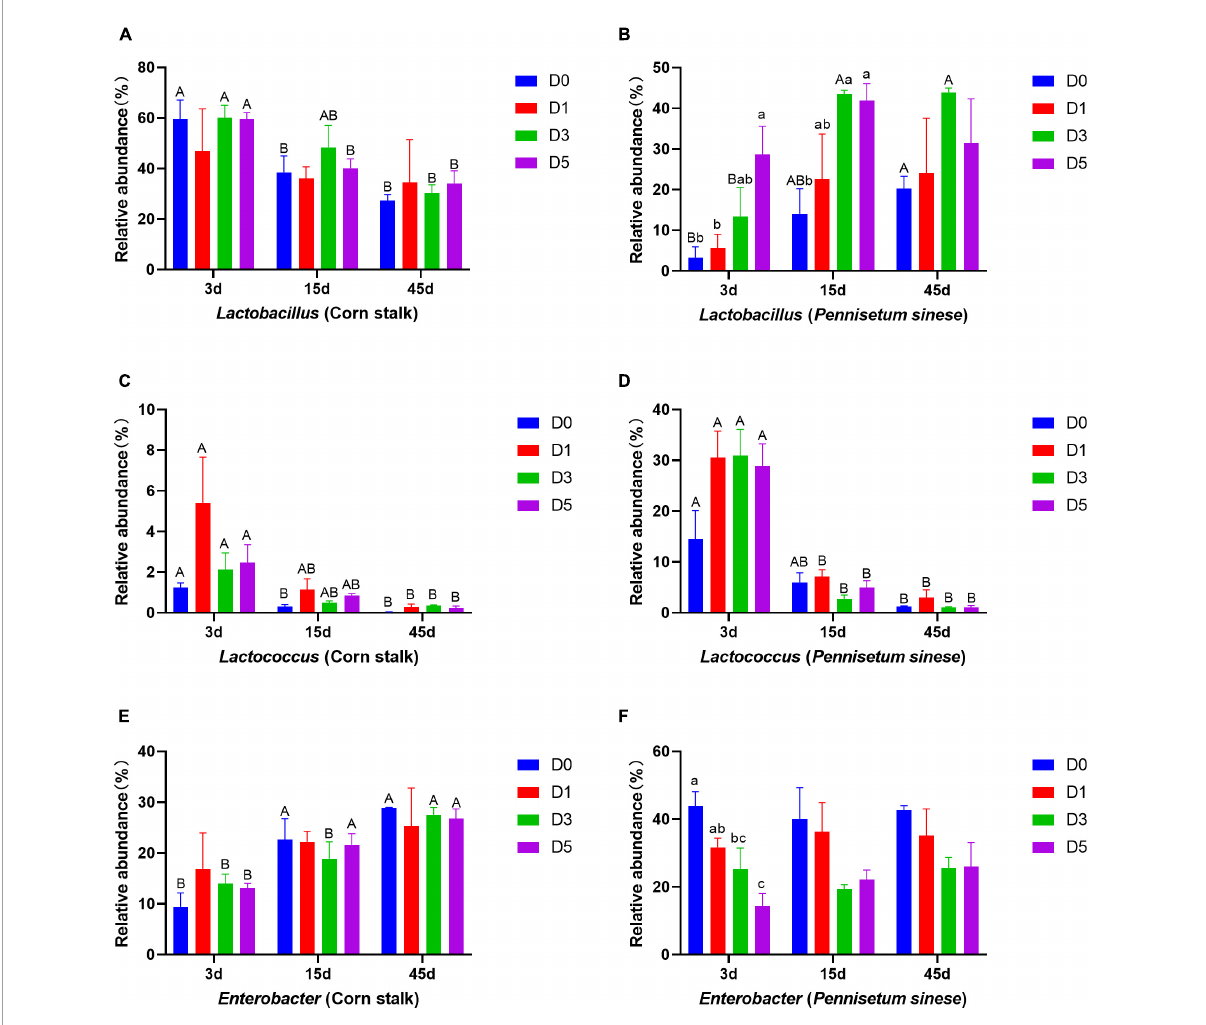
FIGURE3 Changes in the relative abundances of dominant bacterial genera, including Lactobacillus [corn stalk, (A) ; Pennisetum sinese , (B) ], Lactococcus [corn stalk, (C) ; P. sinese , (D) ], and Enterobacter [corn stalk, (E) ; P. sinese , (F) ], during ensiling. D0, undiluted; D1, 10 - 1 dilution; D3, 10 - 3 dilution; D5, 10 - 5 dilution. Means within the same storage period (a, b, c) or within the same dilution gradient (A, B) with different superscripts differ significantly from each other ( p < 0.05). Error bars indicate standard error of